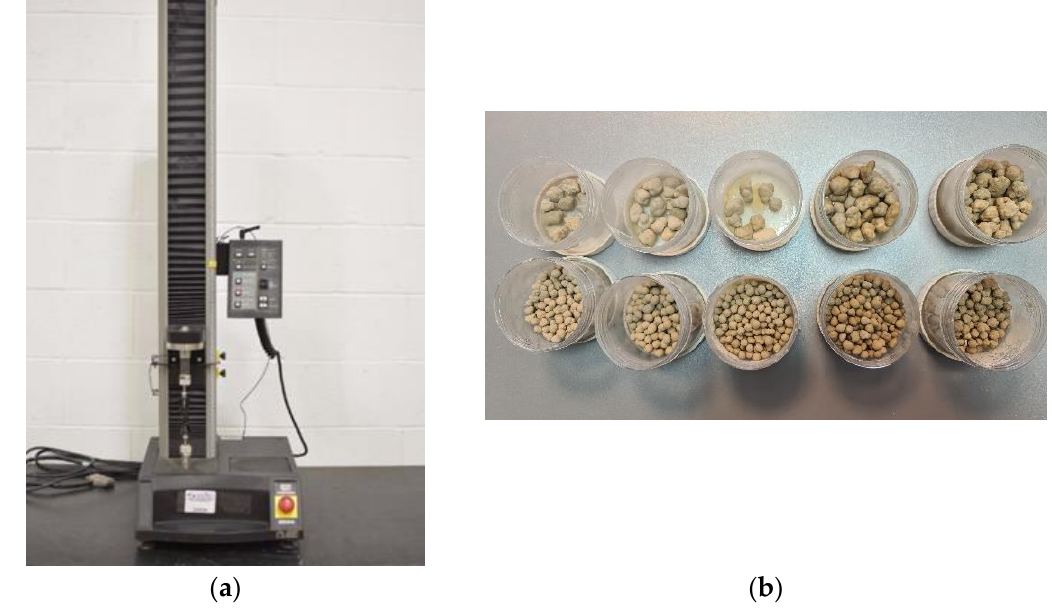
Figure 2. ( a ) Instron device used for compressive strength measurements. ( b ) Granulate samples with a diameter of 5 mm and 10 mm intended for compressive strength tests.